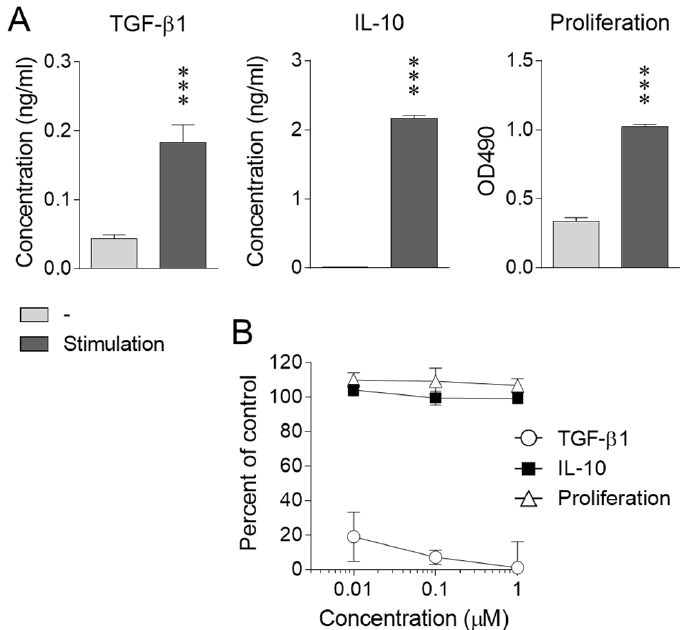
Figure 1. Effect of nicotine on cytokine production and proliferation of iTreg cells. Differentiated iTreg cells were stimulated through CD3/CD28 in the absence ( A ) and presence ( B ) of nicotine. Then, TGF- β 1 and IL-10 production and proliferation were assessed. Data are expressed as means ± SD for cytokine concentrations in the culture supernatants, OD490 values elicited by the proliferation assay reagent ( A ), and percent of cytokine production and proliferation relative to stimulated controls ( B ) ( n = 3). *** p < 0.001, compared with the unstimulated control (Student’s t -test).